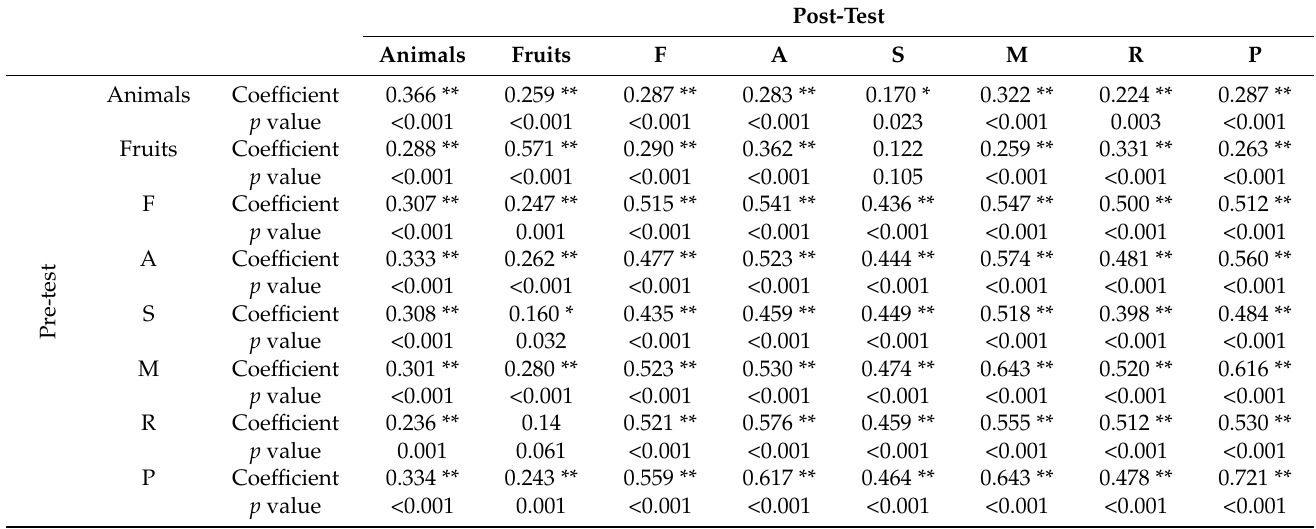
Table 5. Spearman correlation coefficients for phonologic and semantic fluency between pre- and